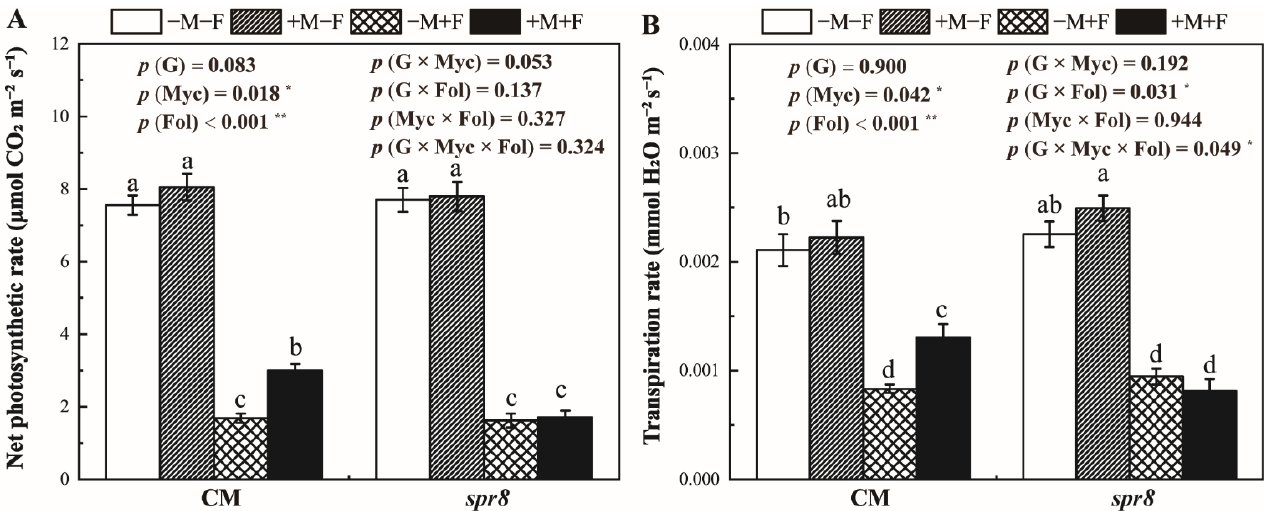
Figure 3. Effects of inoculation with Rhizophagus irregularis (Myc) and Fusarium oxysporum f. sp. Lycopersici (Fol) on the net photosynthetic rate ( A ) and transpiration rate ( B ) of CM and spr8 plants (G). − M and +M represent non-inoculation and inoculation with Rhizophagus irregularis , respectively. − F and +F represent non-inoculation and inoculation with Fusarium oxysporum f. sp. Lycopersici , respectively. Same lowercase letters above the columns indicate non-significant difference ( p < 0.05) between corresponding treatments. *— p < 0.05; **— p < 0.01.